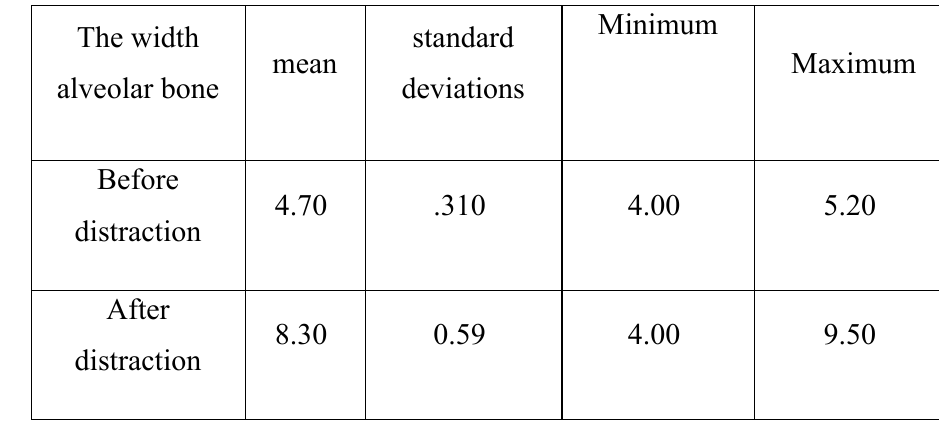
Table 2: Means, standard deviations, and ranges of the width alveolar bone in the distraction osteogenesis (DO).